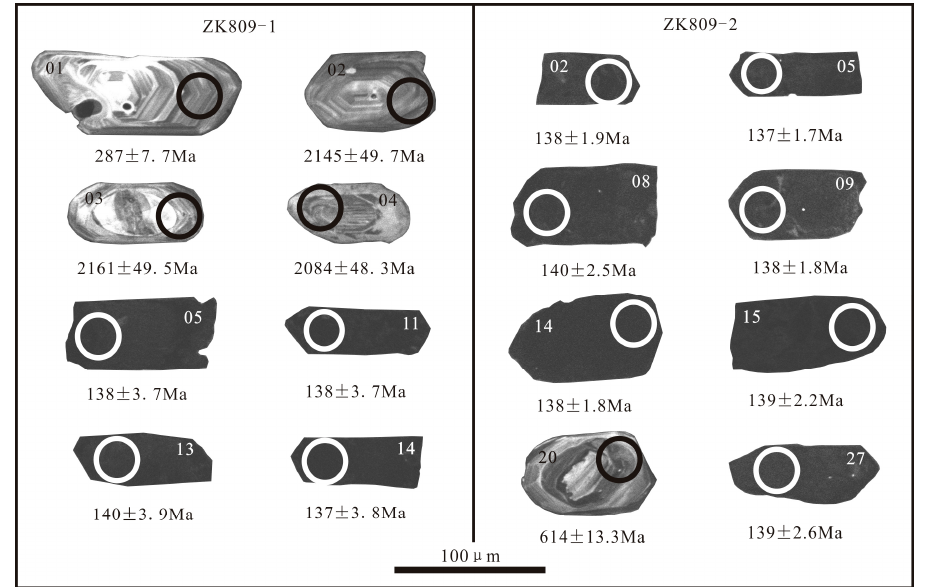
Figure 5. Typical CL images of zircons and analyzed spots from the quartz porphyry in the Weilasituo Sn-polymetallic deposit.